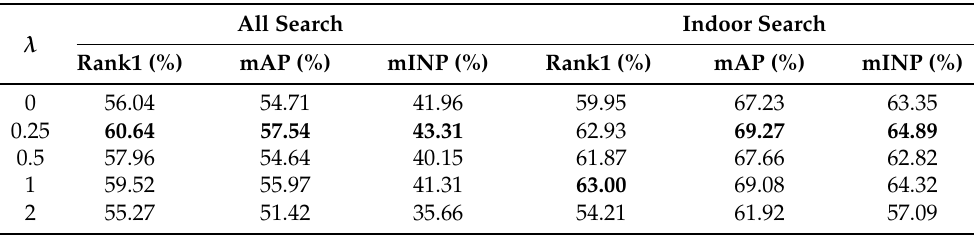
Table 3. The performance comparison of using different weights of MMFSD loss function (i.e., λ in Equation (9)) on the SYSU-MM01